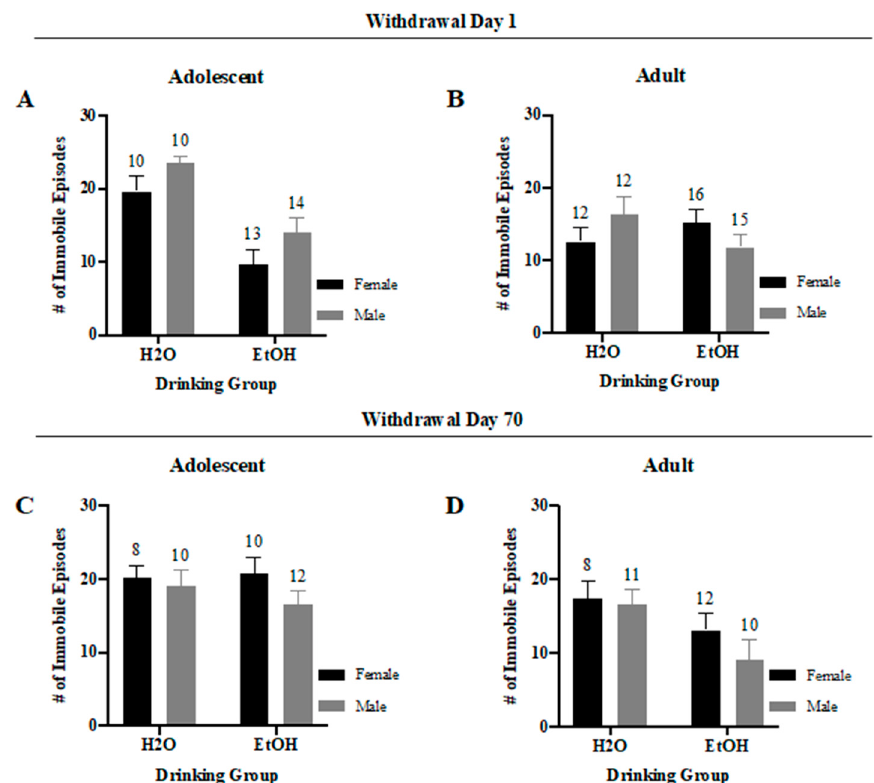
Figure 11. Summary of the results for the Sex × Drinking ANOVA observed for the total number of immobile episodes in the Porsolt Forced Swim Test. ( A ) Depiction of the results for the adolescent-onset mice at 1-day withdrawal. ( B ) Depiction of the results for the adult-onset mice at 1-day withdrawal. ( C ) Depiction of the results for the adolescent-onset mice at 70-days withdrawal. ( D ) Depiction of the results for the adult-onset mice at 70-days withdrawal. The data represent the means ± SEMs for the numbers of mice indicated in each panel.